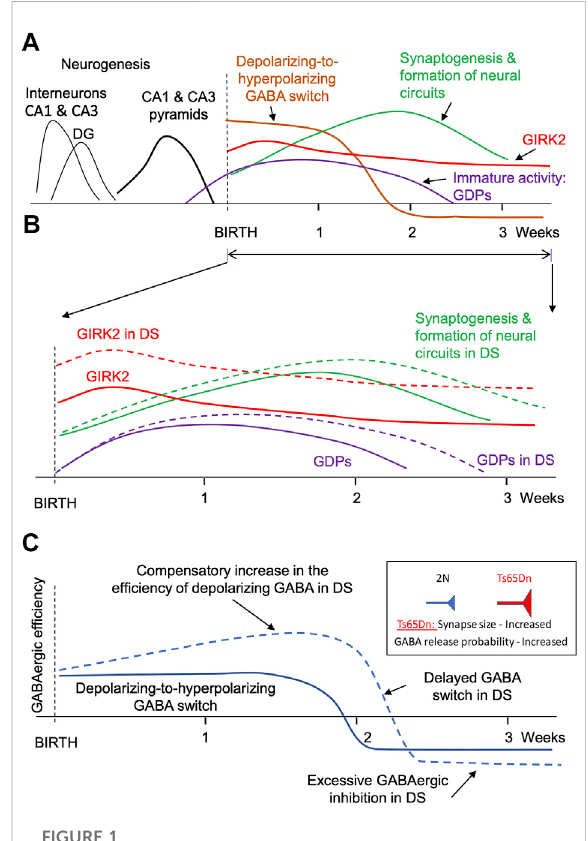
FIGURE 1 Major events during the formation of faulty neuronal circuits in the hippocampus of mouse genetic model of DS. (A) . Main events in the hippocampus of normosomic mice. The time course of neurogenesis (black lines), synaptogenesis (green), GIRK2 expression (red), depolarizing-to-hyperpolarizing GABA switch (brown), and immature giant depolarizing potentials (GDP, purple). (B) . Changes in GIRK2 expression levels (red), immature activity (violet), and neural circuit formation (green). Dashed lines show the changes in DS mice. Note the increase in GIRK2 levels and the prolongation of the period of immature activity in DS models. (C) . Putative changes in the ef fi ciency of GABAergic neurotransmission in the hippocampus of mouse genetic models during early postnatal development. Note a compensatory elevation of the depolarizing GABAergic ef fi ciency before the GABA switch. The increased GABAergic excitation turns into an increased GABAergic inhibition after the GABA